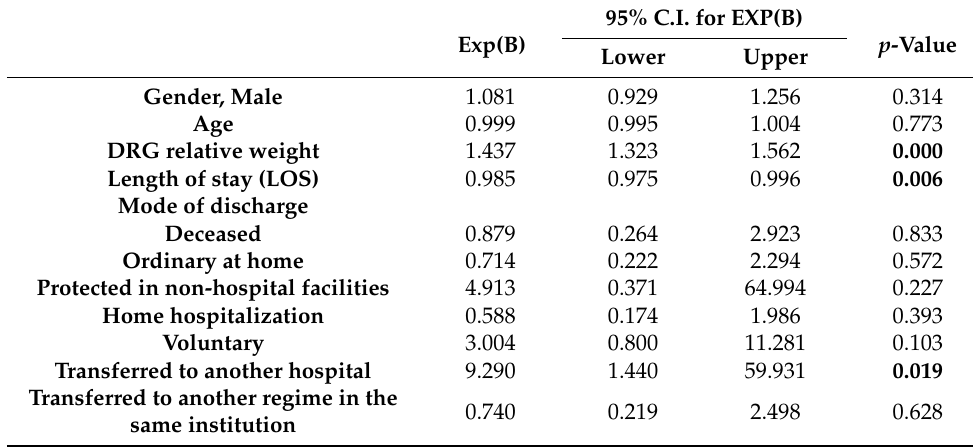
Table 5. Logistic regression—Hospitalized patients.